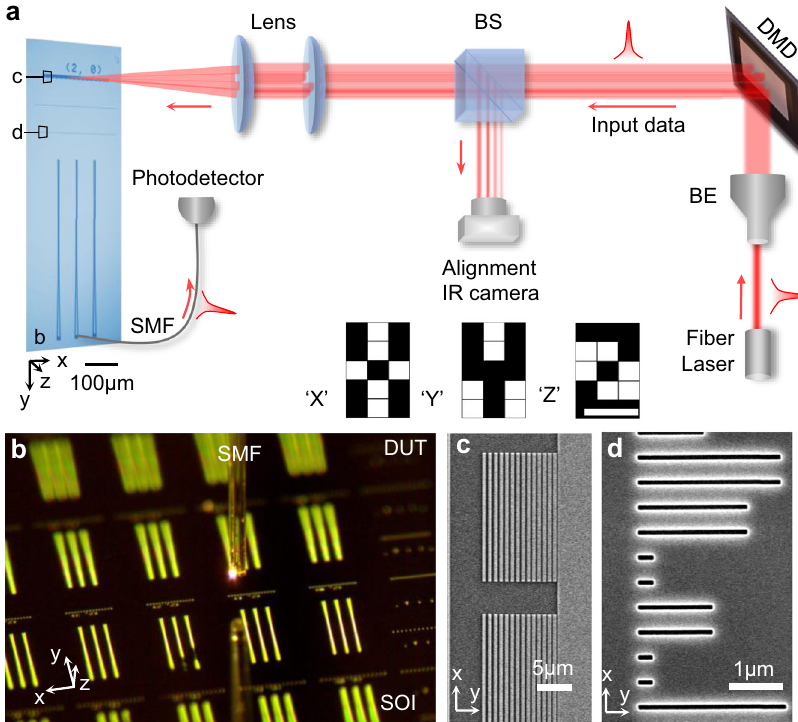
Fig. 2 Device characterization. a The schematic illustration of the confocal set-up. The infrared laser beam is fi rstly expanded by the beam expander (BE). The re fl ection from the programmed micromirror device (DMD) carries the input pattern. The re fl ected image is then focused on the input grating couplers arrays. The output signal is coupled to a single-mode fi ber (SMF) through a grating coupler. An IR camera is used to monitor the light coupling on and off the chip through a beam splitter (BS). The bottom insets are the input images for the letter ‘ X ’ , ‘ Y ’ , and ‘ Z ’ . b The device under test (DUT) includes arrays of metasystems fabricated on a silicon-on-insulator (SOI) substrate. c SEM images show the nanostructure of the input grating coupler array and (d) metasurface